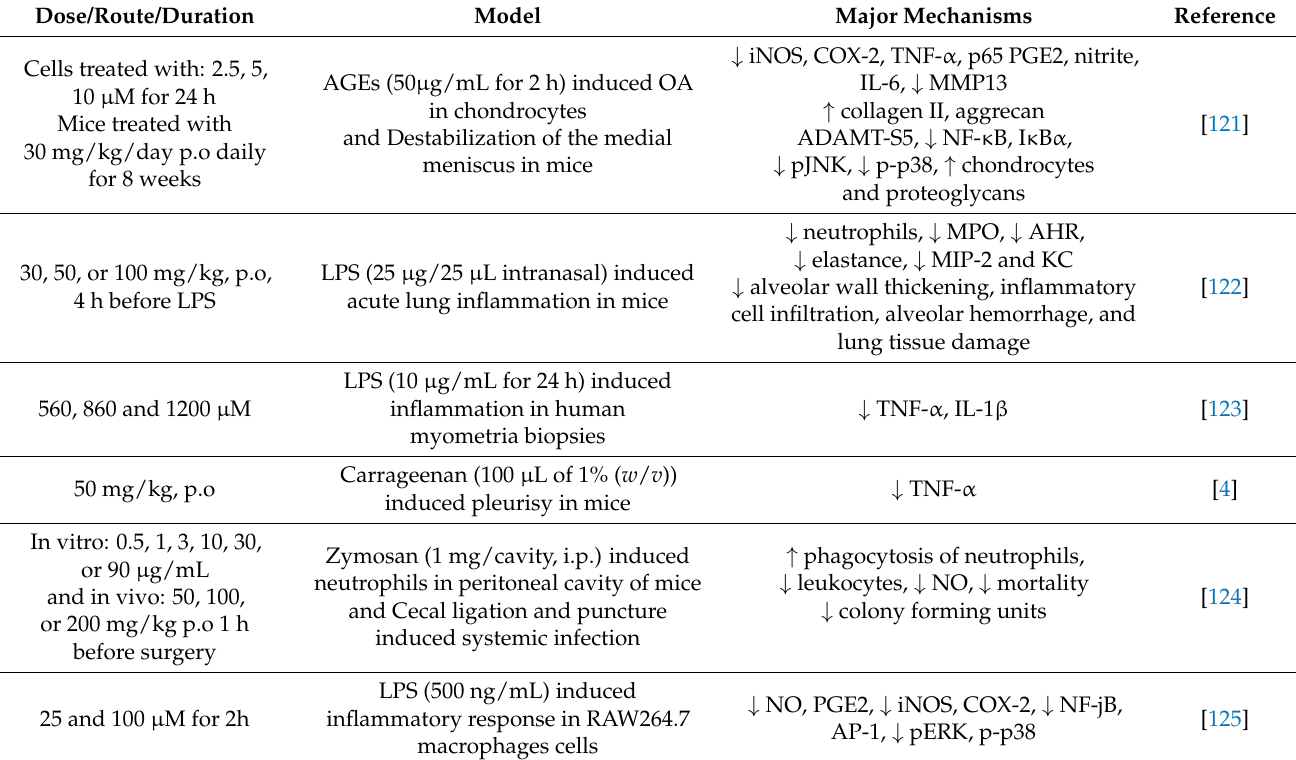
Table 11. Table 11. Anti-inflammatory effects of α -Bisabolol in different experimental